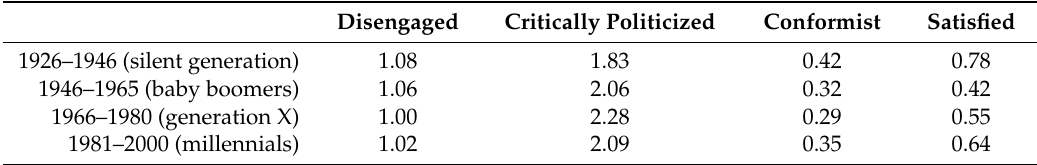
Table 2. Relative change in the predicted probabilities of attitudes towards politics after 15-M compared to years before, by birth